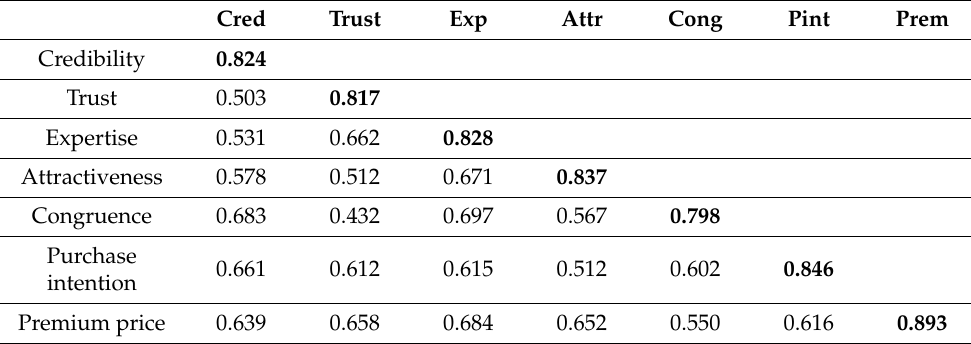
Table 4. Correlations and discriminant validity values.